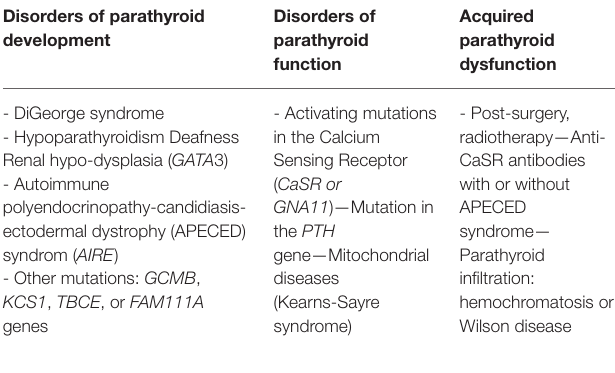
TABLE 1 | Etiologies of pediatric